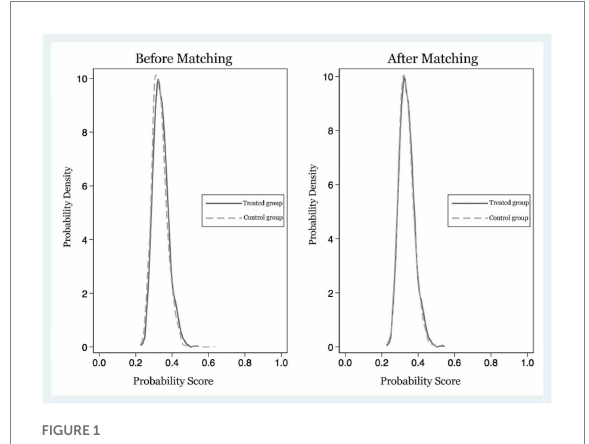
FIGURE 1 P-score fit before and after overall sample